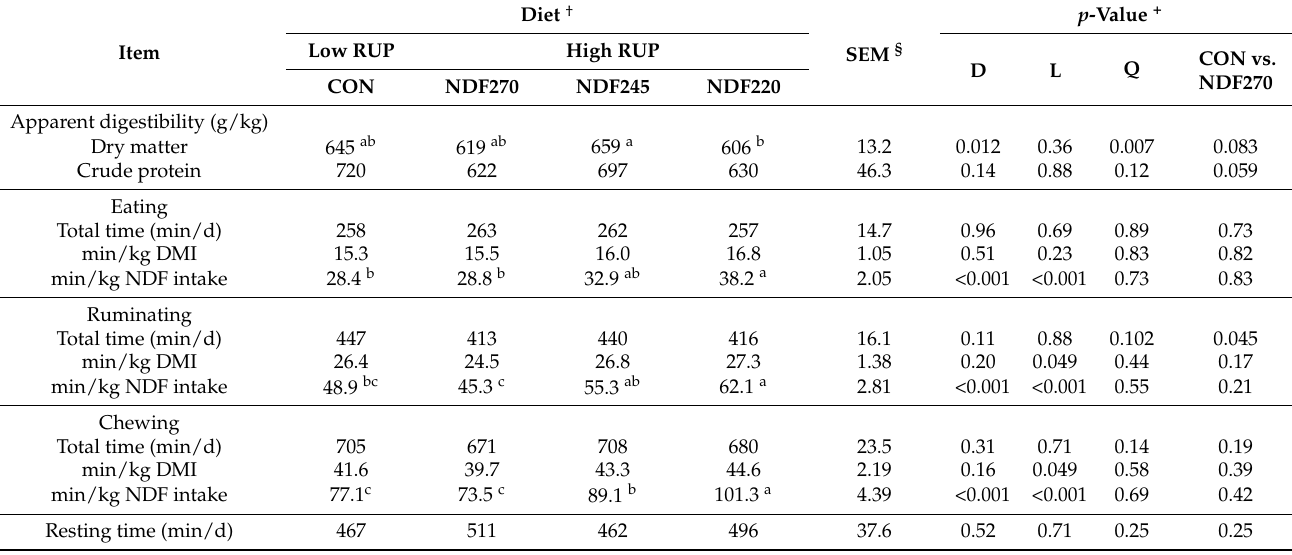
Table 4. Effects of feeding various levels of neutral detergent fiber (NDF) and rumen undegradable protein (RUP) on apparent nutrient digestibility and eating patterns of fat-tailed